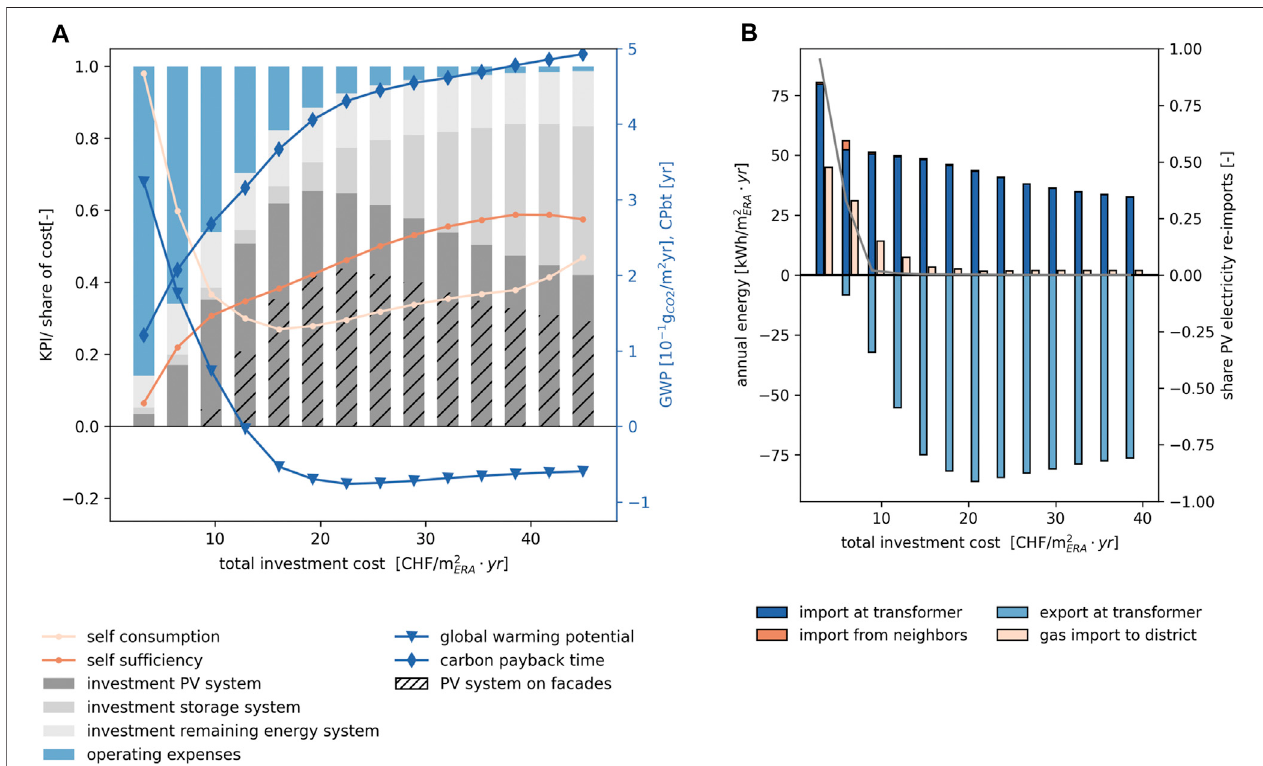
FIGURE 6 | Results of the MOO of 31 buildings in one low-voltage grid, normalized to total ERA in the district. (A) performance indicators and cost distribution of identi fi ed energy systems; (B) electricity exchange and gas imports for the district.